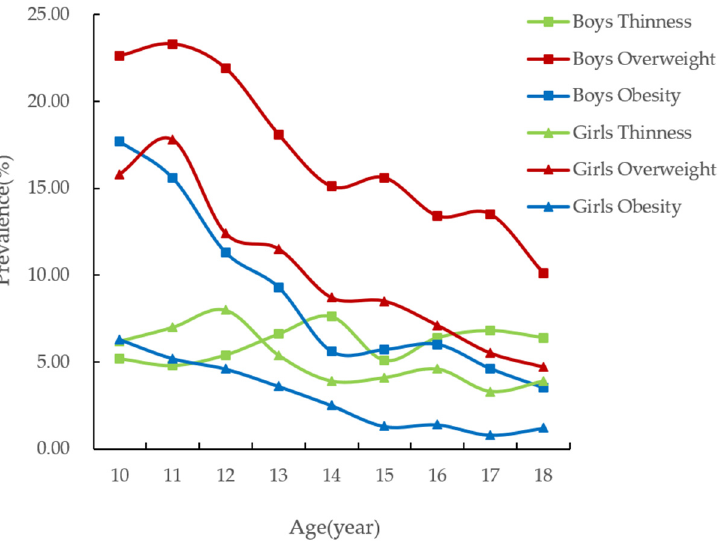
Figure 1. Prevalence of different nutritional status in children and adolescents aged 10 – 18 years (%).